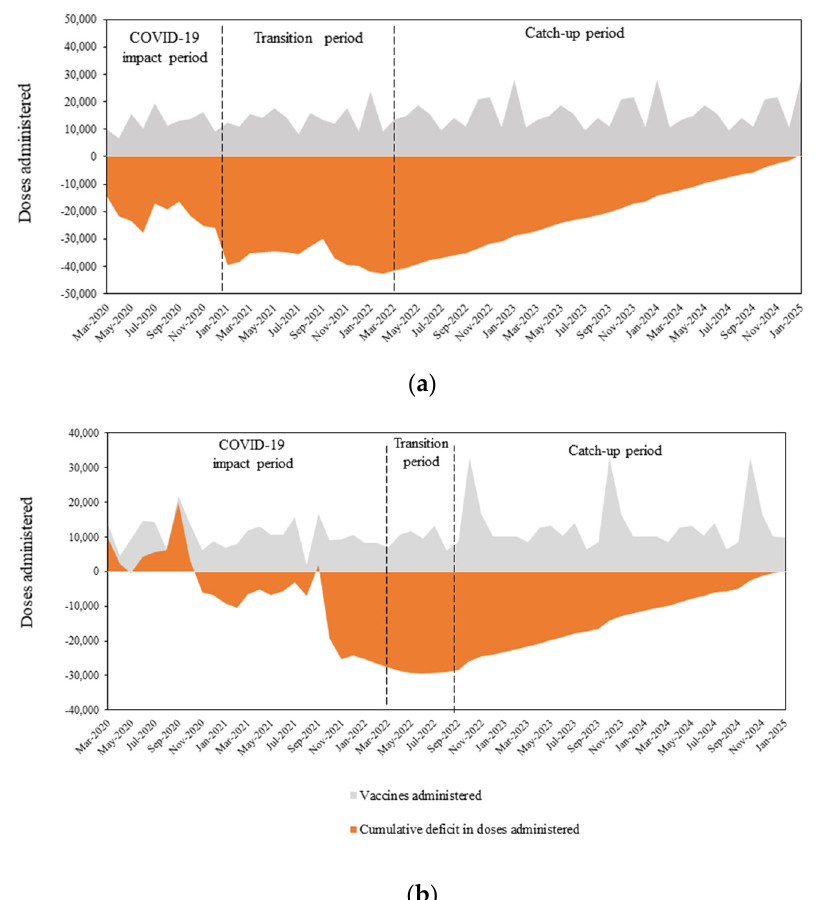
Figure 2. Deficits in vaccine doses administered due to the COVID ‐ 19 pandemic and model predic ‐ tions for clearing the cumulative HPV deficit by the end of 2024 in ( a ) Switzerland and ( b )